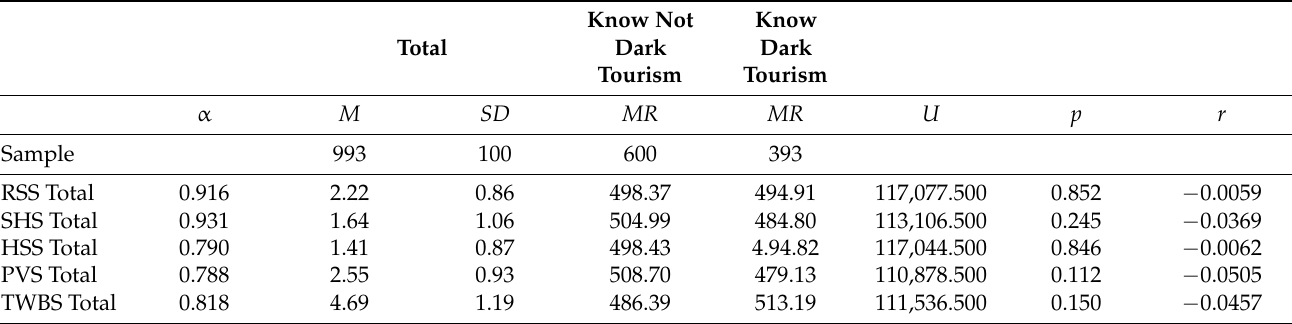
Table 5. Rumination on sadness (RSS), self-hatred (SHS), hostility (HSS), psychological vulnerability (PVS), and tourism wellbeing (TWBS) frequencies and differences between those who know dark tourism and those who do not.